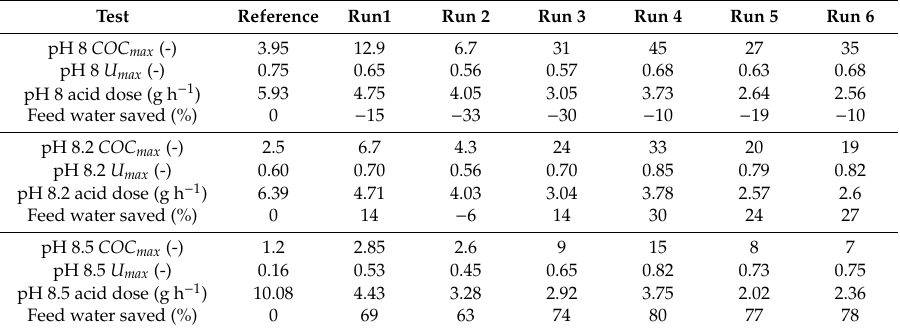
Table 7. MCDI-CT pilot simulation of COC max , U max , acid dosage (g h − 1 ) and feed water saved versus reference test at same pH for reference and test runs. Test